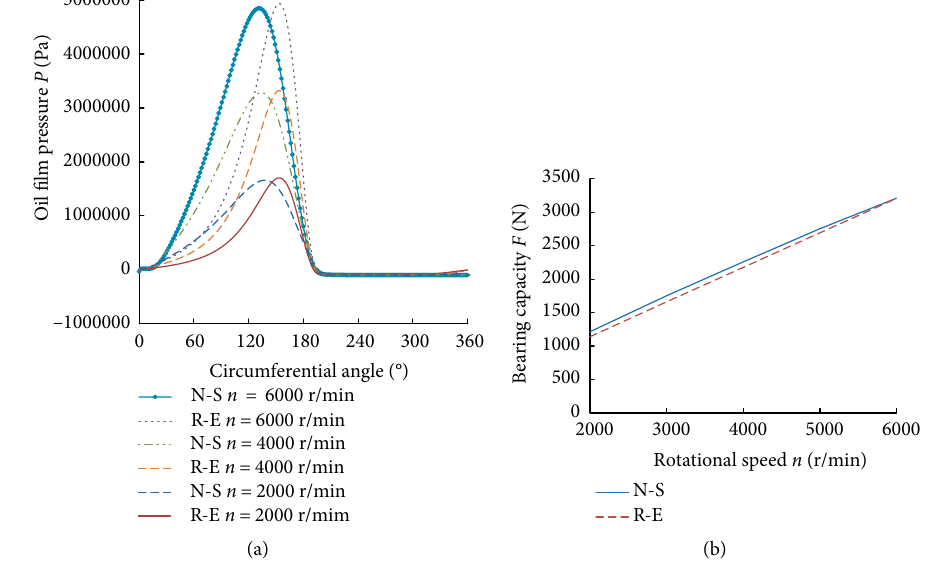
Figure 6: Effect of speed on oil film pressure and bearing capacity. (a) Oil film pressure. (b) Bearing capacity.